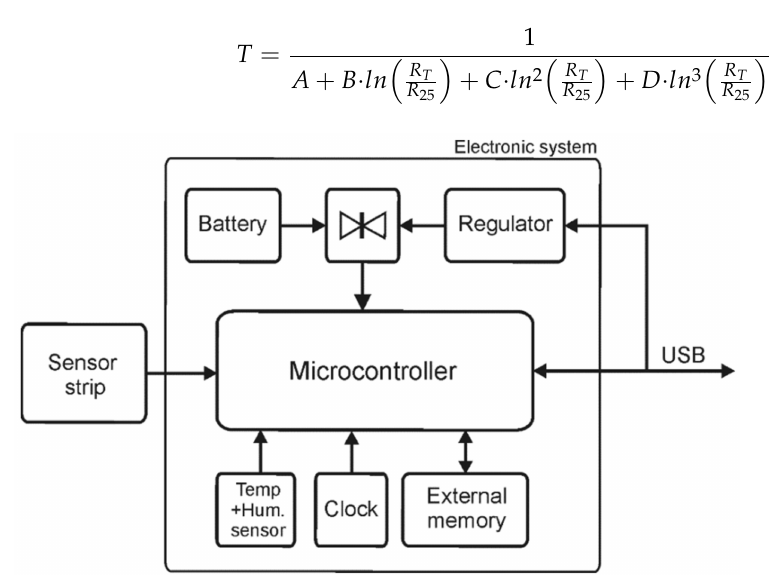
Figure A1. Block diagram of the electronic system.